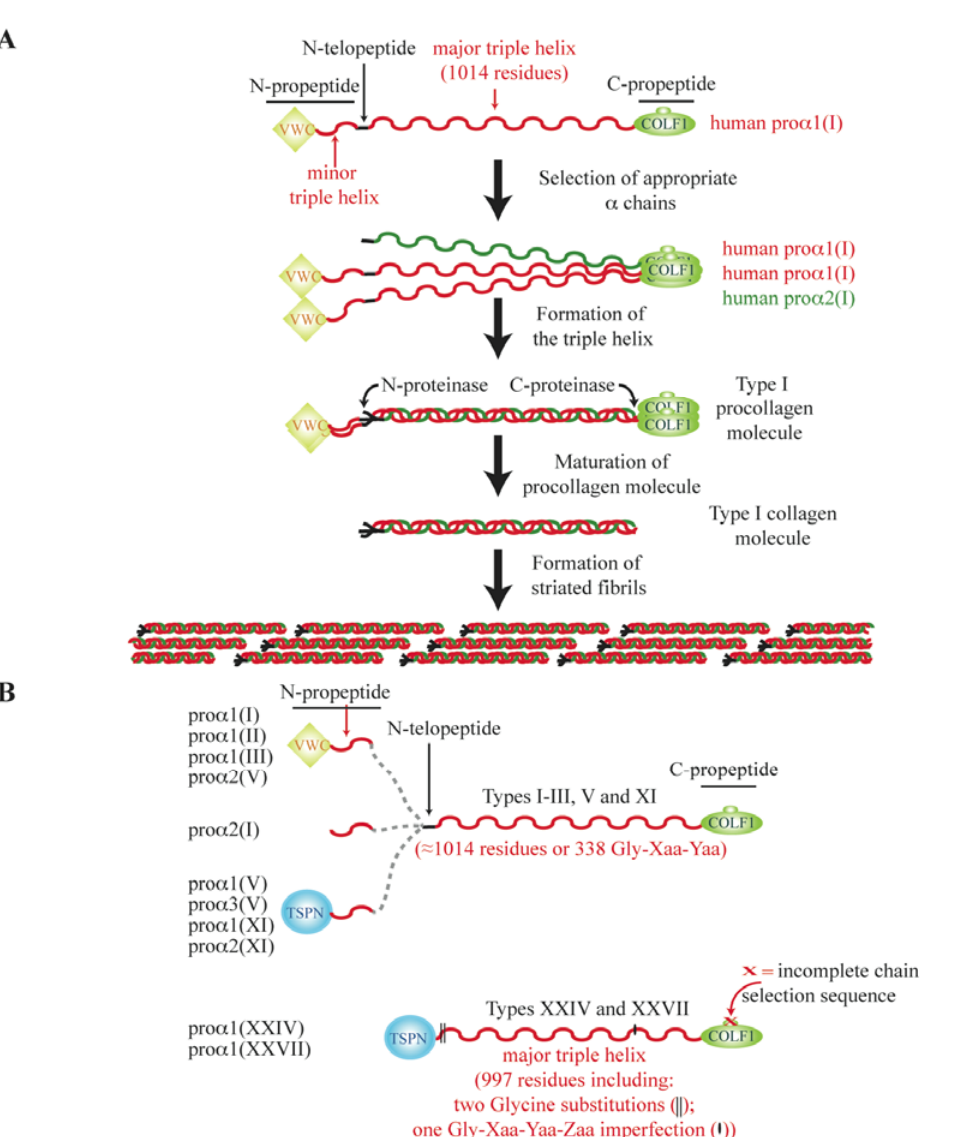
Figure 1. Fibrillar collagen characteristics. (A) From fibrillar  chains to the striated fibrils. To illustrate the different steps leading to the formation of collagen fibrils, we have chosen human type I collagen. After the selection of appropriate  chains, the C -propeptides play a fundamental role in alignment and registration of  chains, permitting nucleation of the triple helix and its elongation in a C - to a N -terminal direction. Then, the procollagens are processed by N - and C- proteinases, and the resultant collagen molecules aggregate to form the fibrils. (B) Modular structures of human fibrillar collagen chains. Dashed lines are used to illustrate the three different N -propeptide modular configurations found in human types I-III, V and XI. (C) Different N -propeptide architectures of metazoan fibrillar collagen chains. (+) indicates that at least one  chain presents this type of N -propeptide. In the case of cnidarian data, (+  a) signifies that these N -propeptide modular structures have not been characterized to date, but are present either in hydra or in sea anemone. (?b) indicates that phylogenetic analysis has indicated that the sea urchin 7  chain is related to vertebrate types XXIV and XXVII, but that the N -propeptide of this fibrillar collagen is still unknown